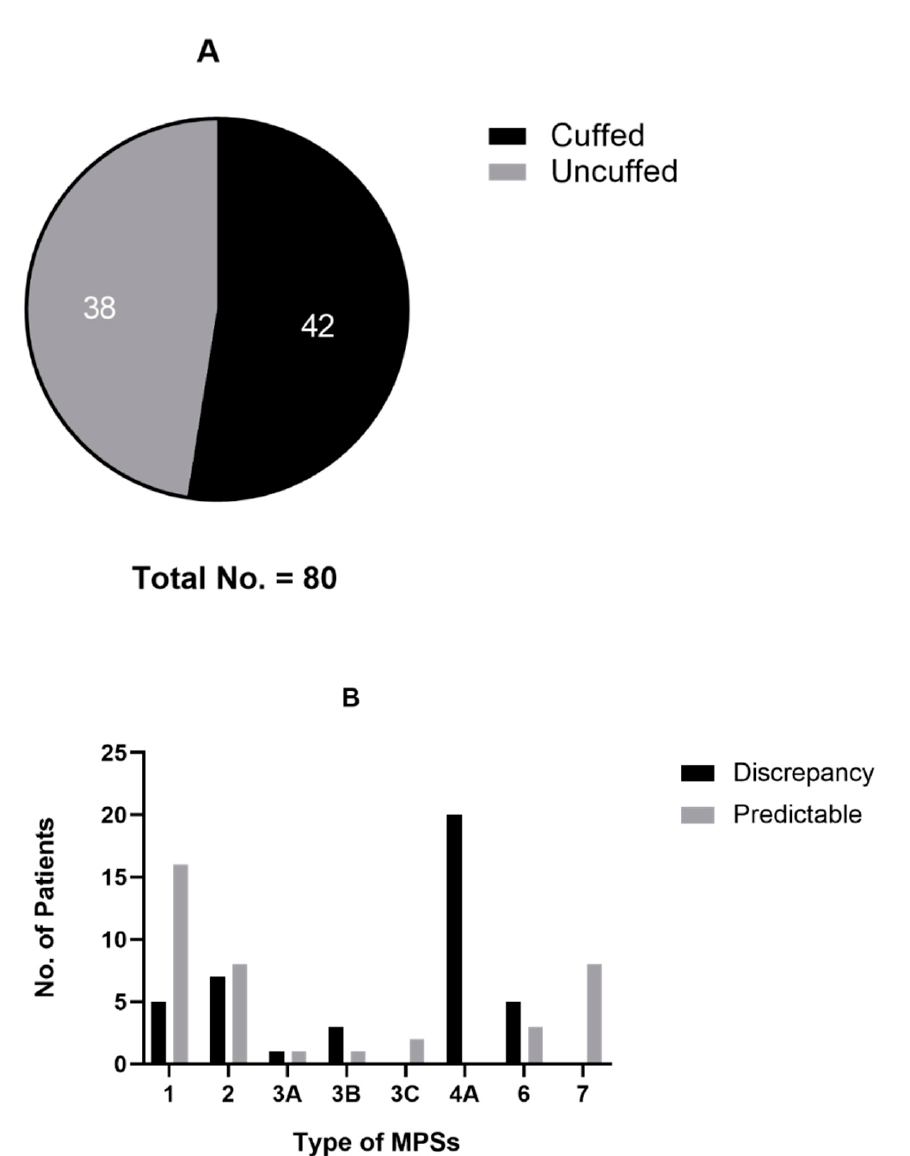
Figure 2. Choice of endotracheal tube: ( A ) Number of cuffed or uncuffed tubes. Cuffed endotracheal tube (black) was lightly preferable (52.5%) to uncuffed (grey) tube; ( B ) Discrepancy of tube size. Inner diameter smaller or larger than 0.5 mm of estimated tube size was recognized as discrepancy (black bar).